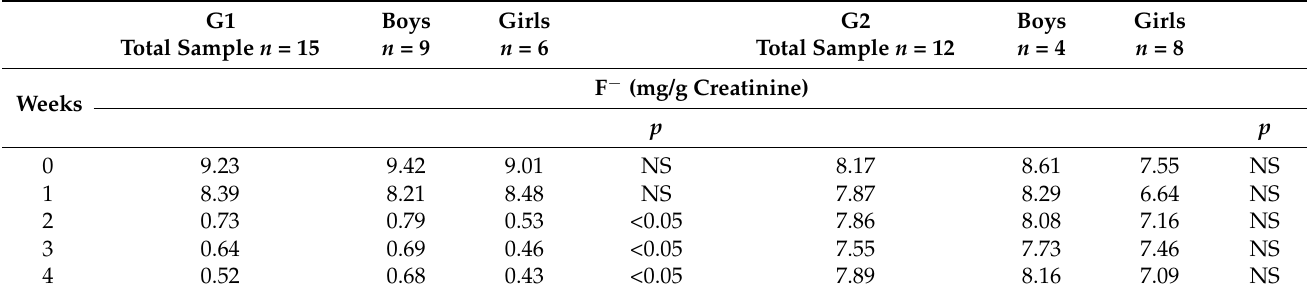
The values are the median concentrations of F − (mg/g creatinine) in the treated group (G1) and untreated group (G2). Week zero represents the baseline measurement of the corresponding study group (NS: no significant difference between males and females in the same group per week according to the Mann–Whitney U test).